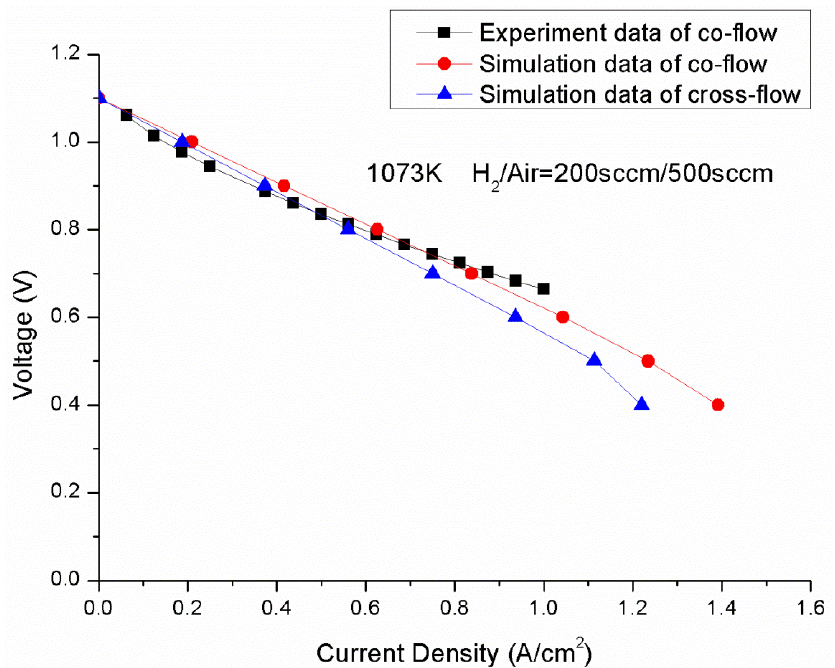
Figure 3. Comparison of the predicted V - I curve from CFD model with experimental data at the same operating